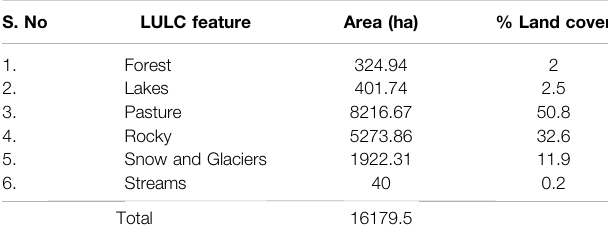
TABLE 4 | LULC characteristics of the catchment area of the fi ve high altitude lakes during 2020. S.